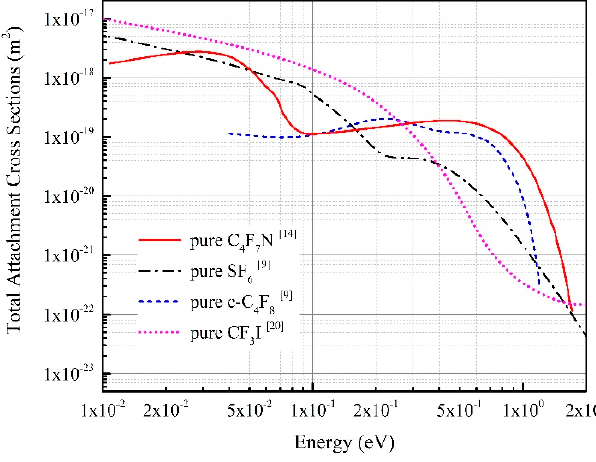
Figure 2. Comparison of total attachment cross-sections of C 4 F 7 N, SF 6 , c-C 4 F 8 , and CF 3 I.